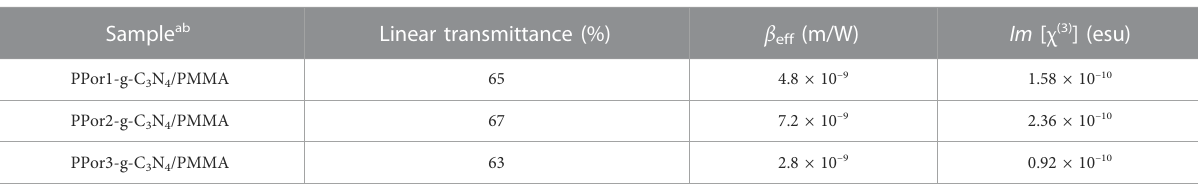
TABLE 2 NLO properties of as prepared samples in PMMA.